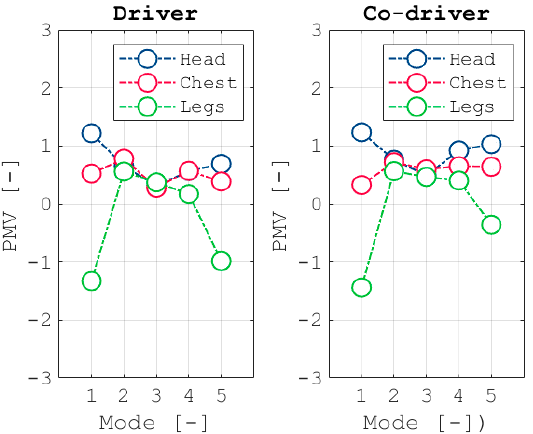
Figure 11. PMV value vs. HVAC mode: (left) driver; (right) co-driver.